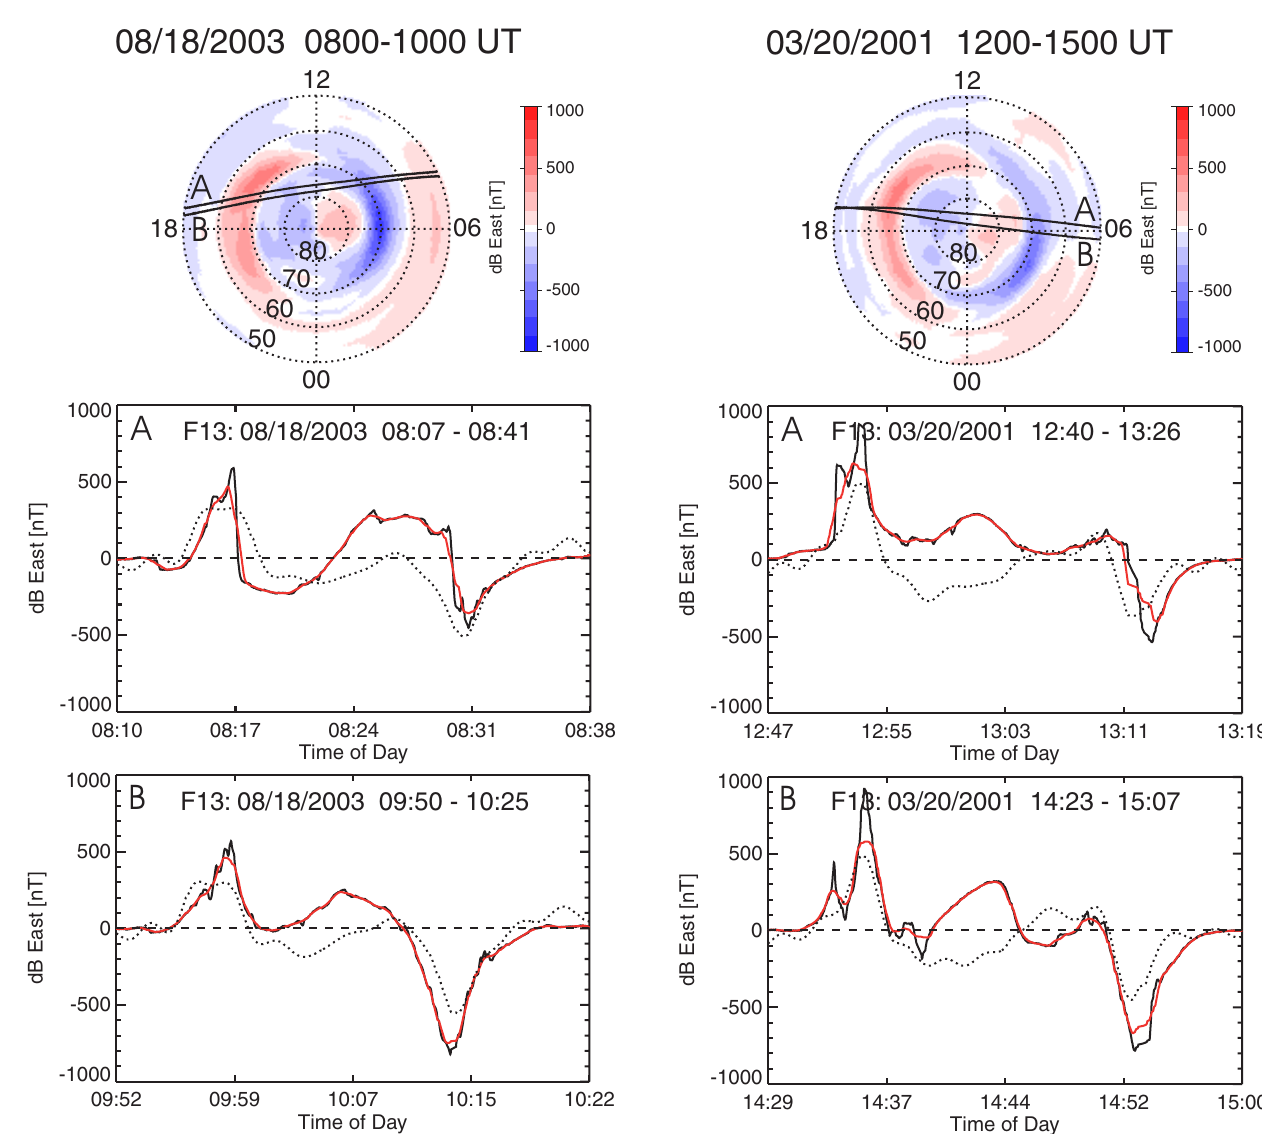
Fig. 10. Comparison of the fitted magnetic perturbations from Irid- ium (dotted line) with DMSP F13 observation (solid black line) dur- ing the interval 20 March 2001, 12:00–15:00UT. The red solid line shows the 50s boxcar average of the DMSP F13